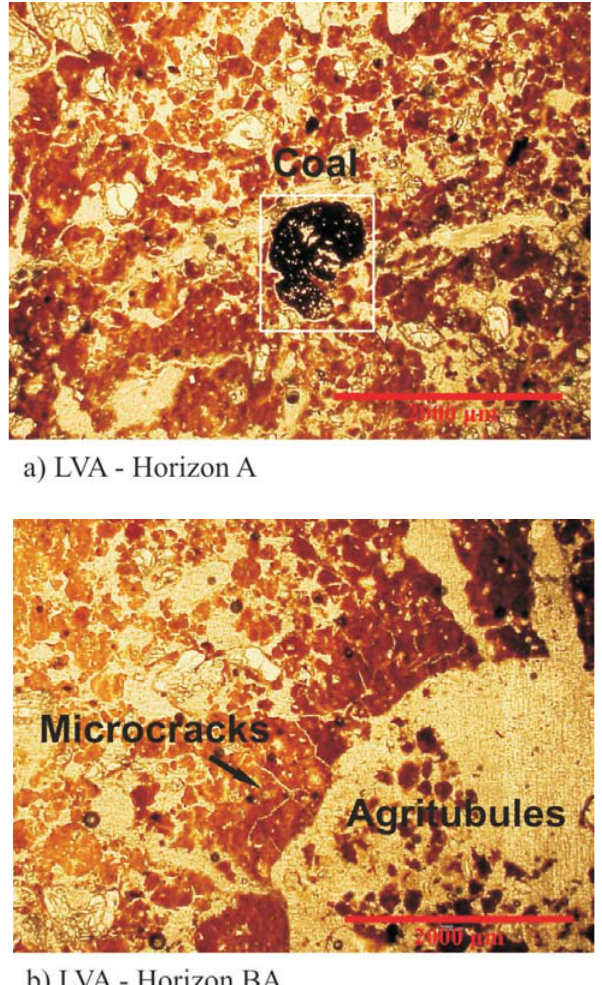
Figure 8. Photomicrographs (under ambient light) of LVA horizons: (a) porphyric-enaulic zone and coal with microaggregates in the A horizon of the LVA; (b) microfissures and agrotubules filled with clay, quartz, and iron oxides composing the BA horizon of the